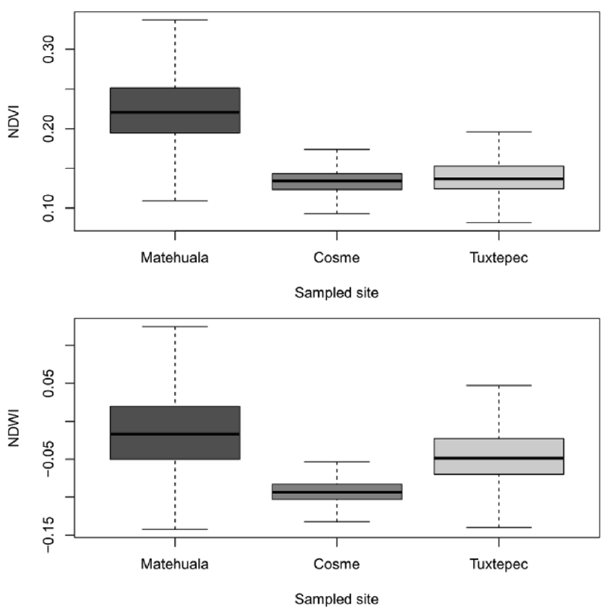
Figure 1. Statistics summary of normalized difference vegetation index (NDVI) and normalized difference water index (NDWI) values obtained by location from Landsat 8 imagery captured on 20 August 2018. Horizontal line = median, box = interquartile range (IQR), whiskers = 1.5 × IQR below first quartile or above third quartile.